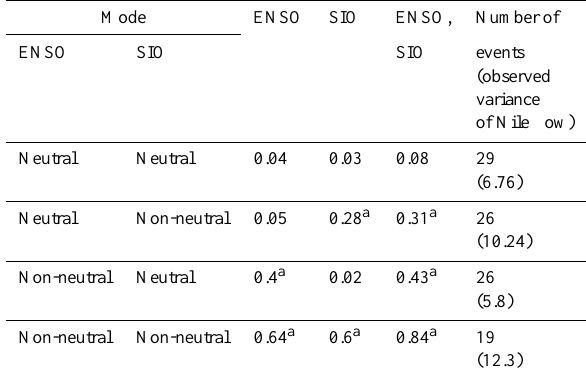
Table 1. Summary of the coefficient of determination ( R 2 ) between the average Nile flow from July to October and different combina- tions of indices of ENSO and